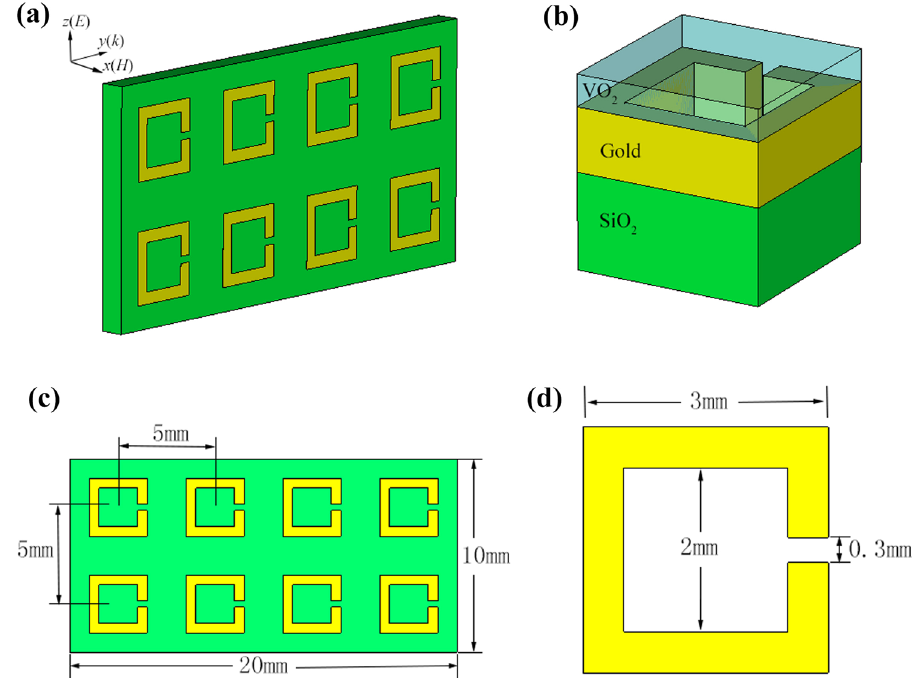
Figure 1. Power-tunable microwave VO 2 metamaterial designs. ( a,b ) Schematic view of the sample that consists of a SiO 2 substrate, VO 2 thin film and gold split-rings. ( c,d ) Size parameters of the